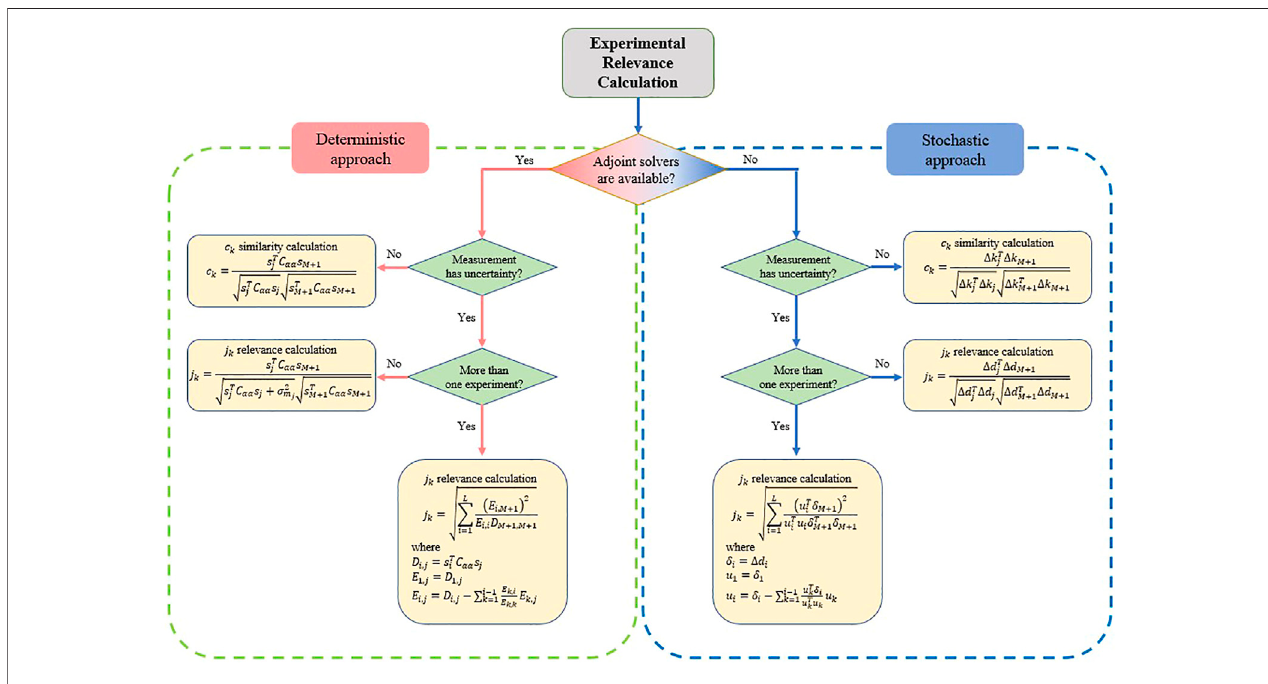
FIGURE 6 | Approach for evaluating experimental relevance.